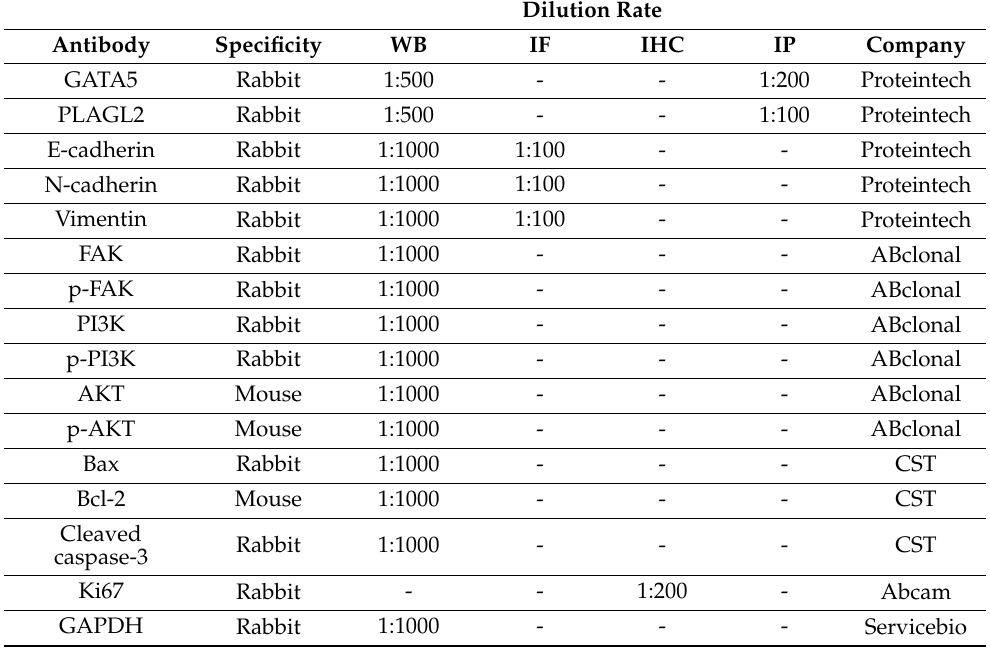
Table 1. All the primary antibodies applied for the